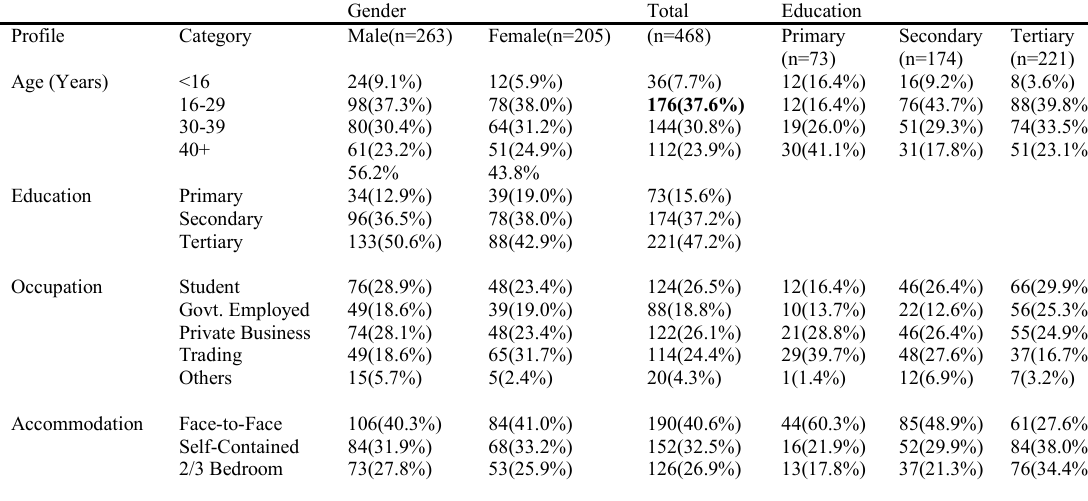
Table 1: Demographic information of the study area